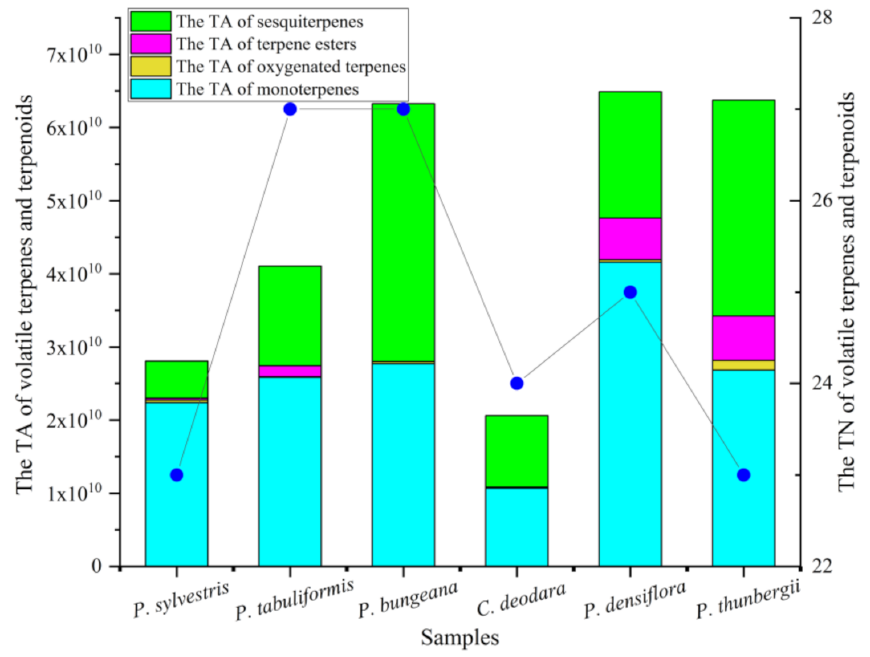
Figure 1. Comparison of volatile terpenes and terpenoids in pine leaves. TA refers to total area. TN refers to total number. The blue dots refers to the TN of volatile terpenes and